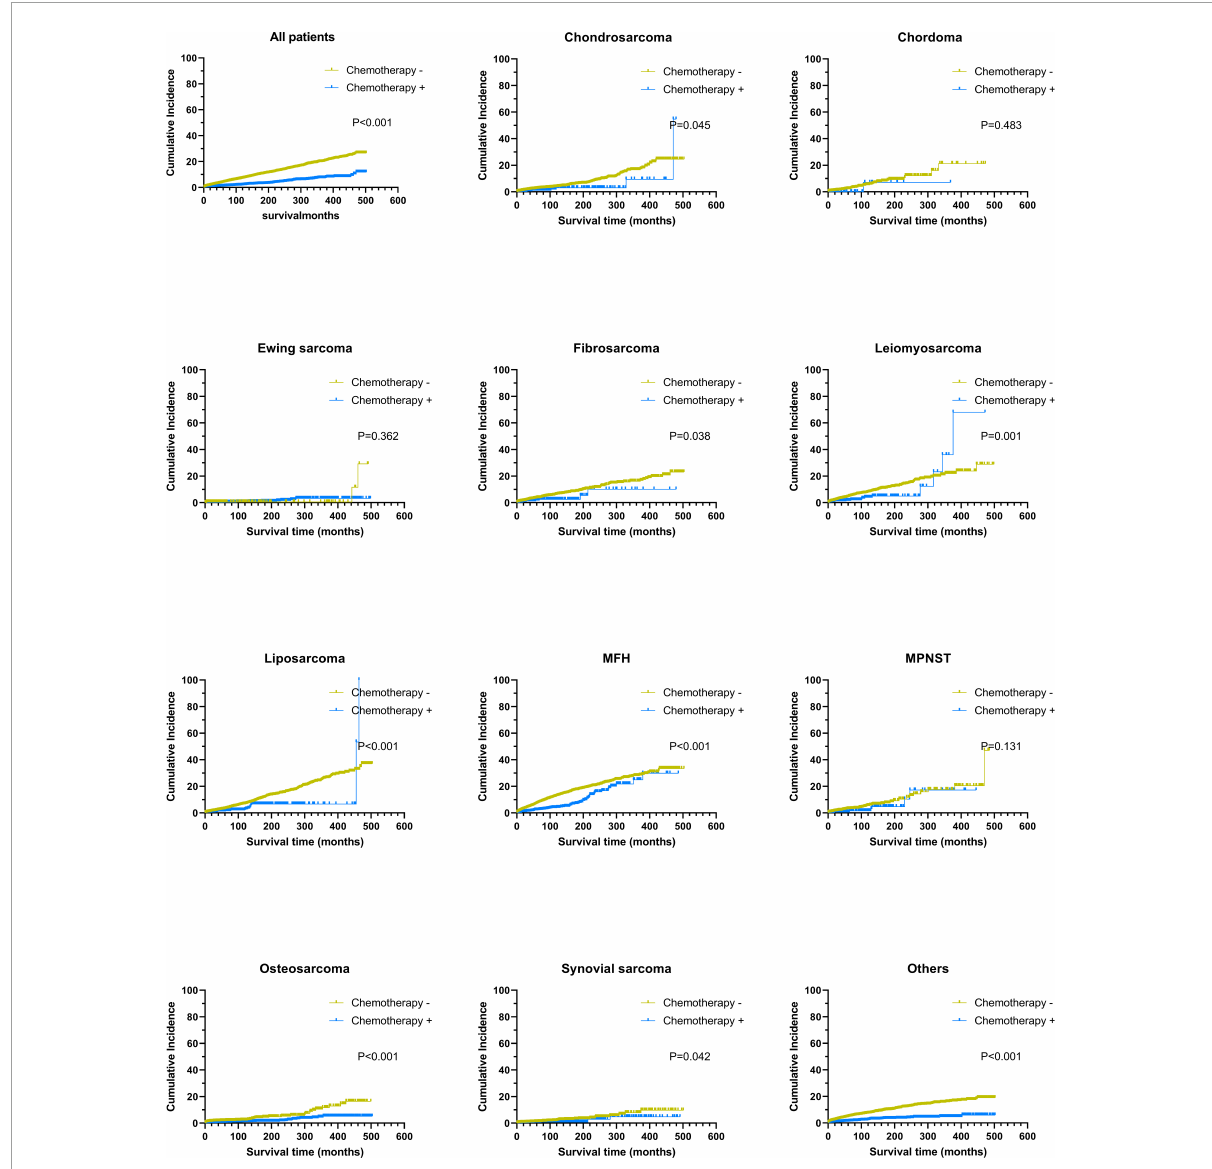
FIGURE3 Subgroup analysis: the graph showed cumulative incidence curves of death resulting from heart events. MFH, malignant fibro histiocytoma; MPNST, malignant peripheral nerve sheath